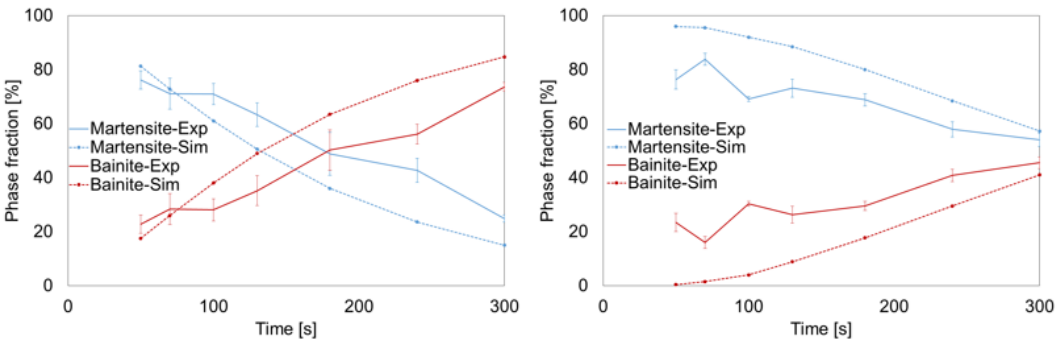
Figure 5. Comparison of the results from the simulation and the experiment of phase fraction as a function of cooling time and C-content ( left : 0.21%, right : 0.281%) for the compromise model [23].